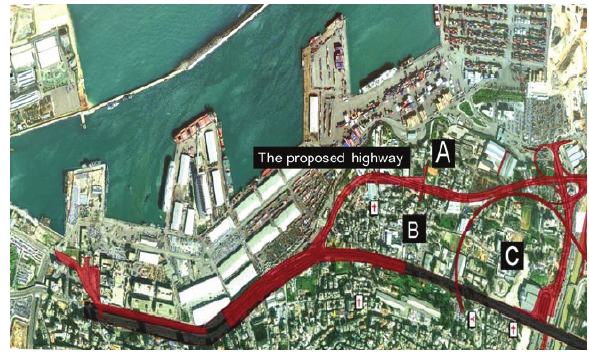
Figure 4. The impact of the new proposed highway and